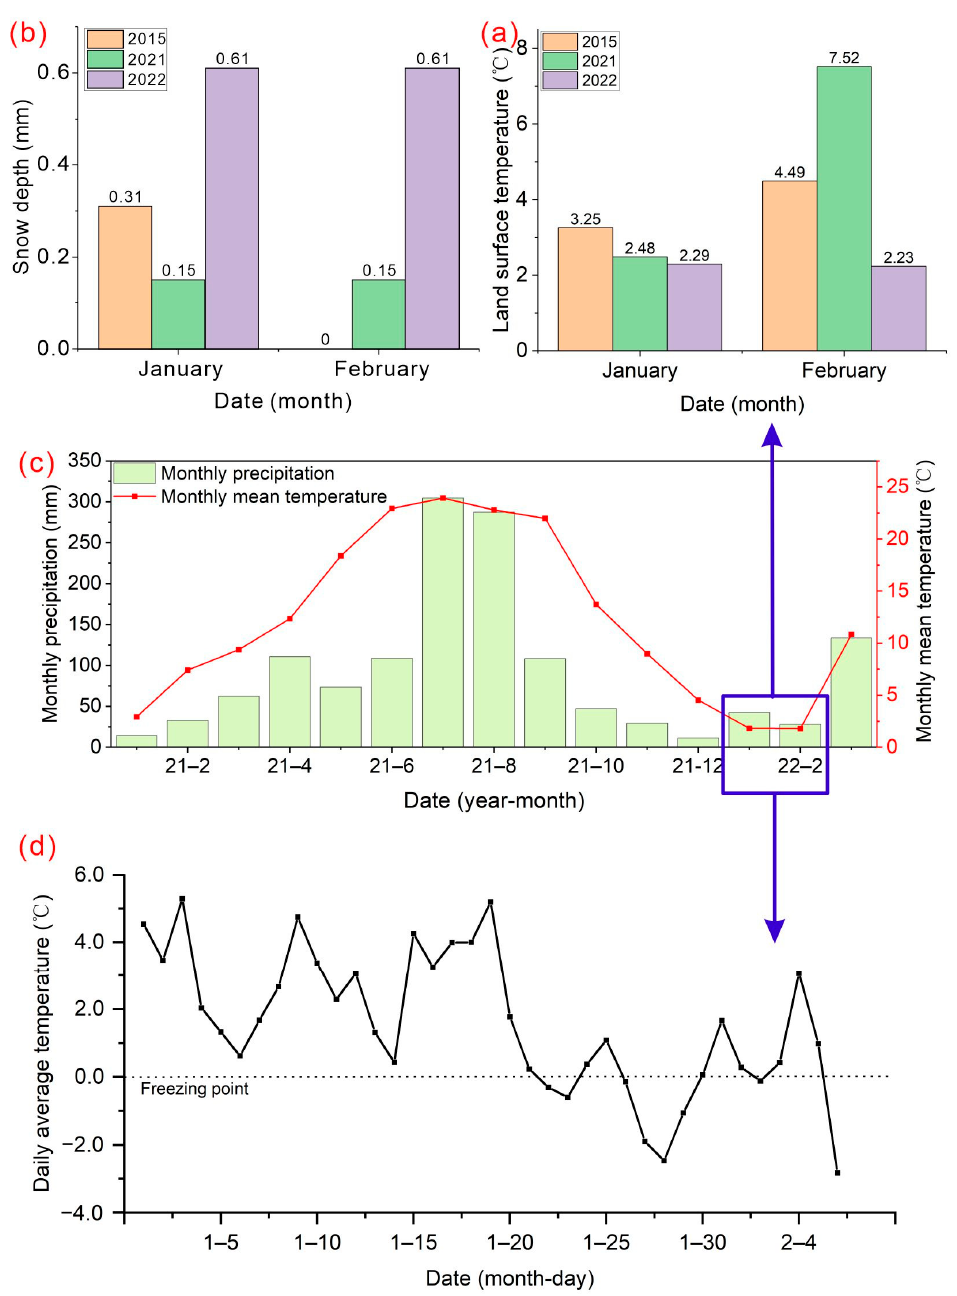
Figure 3. Comparison of the weather conditions in the studied area in 2021 and January and Febru- ary of 2015, 2021, and 2022: ( a ) Comparison of snow depth in January and February in the study area; ( b ) Comparison of surface temperature in January and February in the study area; ( c ) Climate conditions in the study area from January 2021 to March 2022; ( d ) Daily air temperature changes before and after the collapse of Yizhuxiang in the study area.